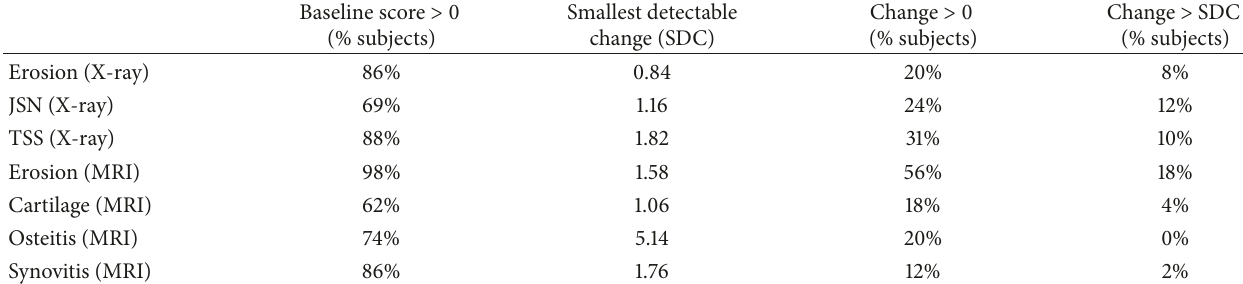
Table 3: Proportion of subjects showing radiographic and MRI involvement at baseline and change at Week